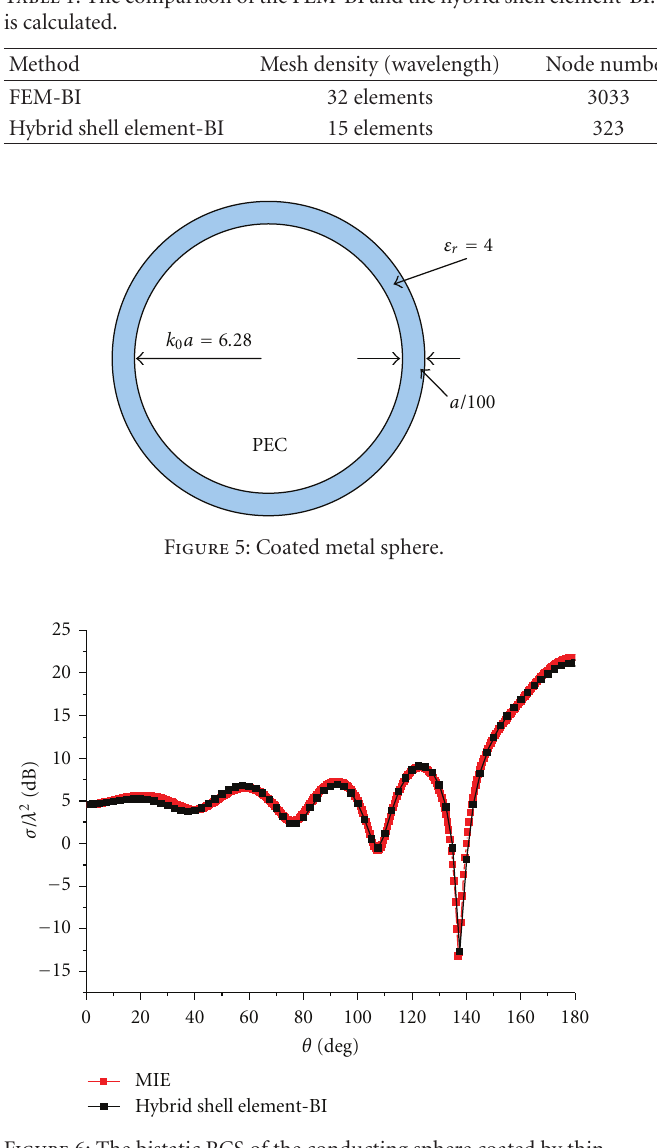
Figure 8: The bistatic RCS of the coated metallic